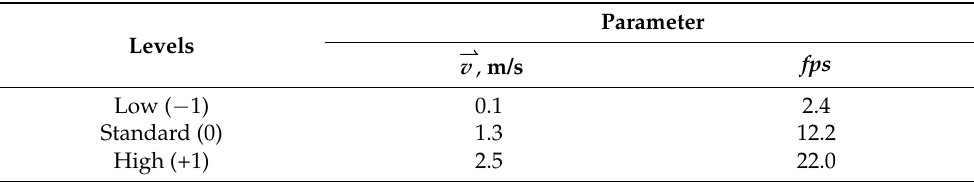
Table 1. Complete factorial design to determine the detection rate of a CNN-based vision system for agricultural field operation using simulation.